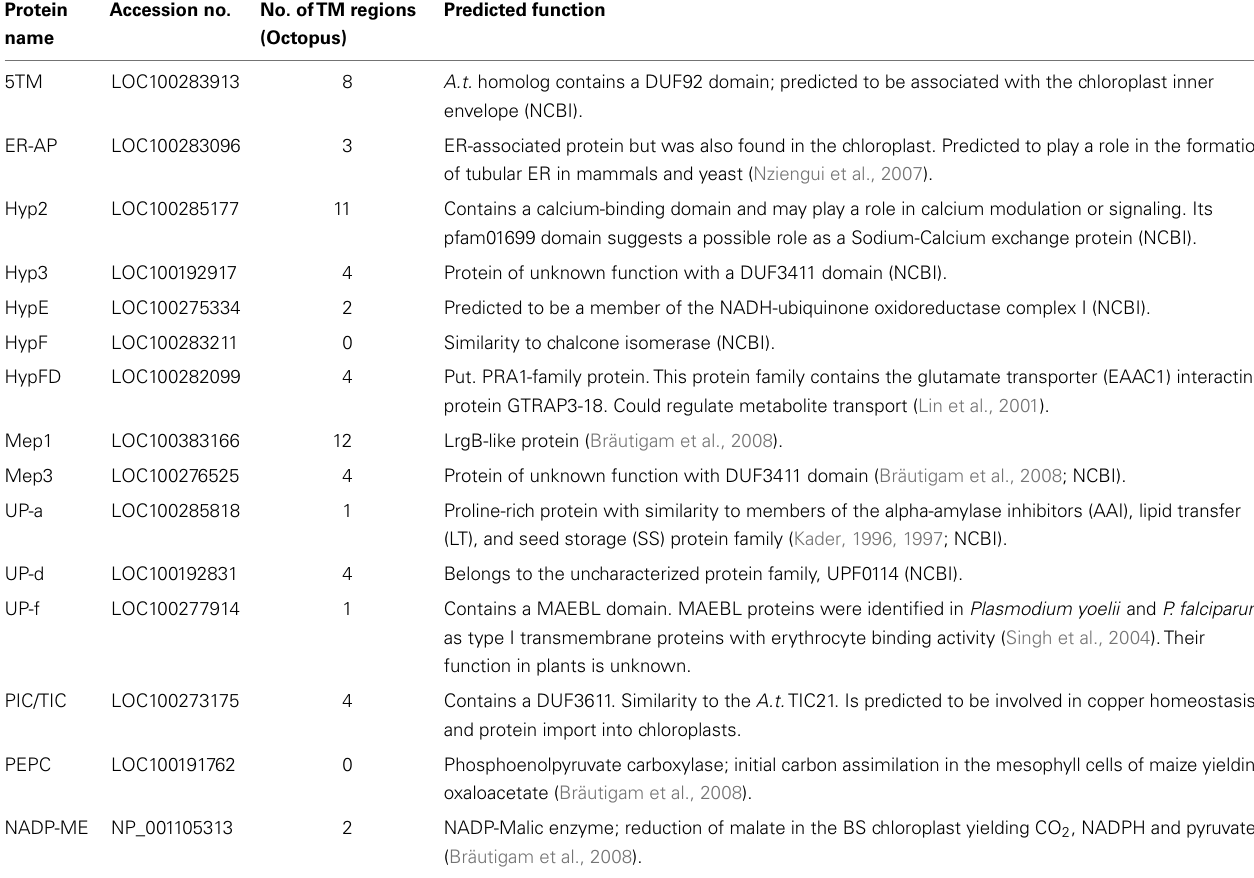
Table 1 | List of proteins used for further study and their predicted